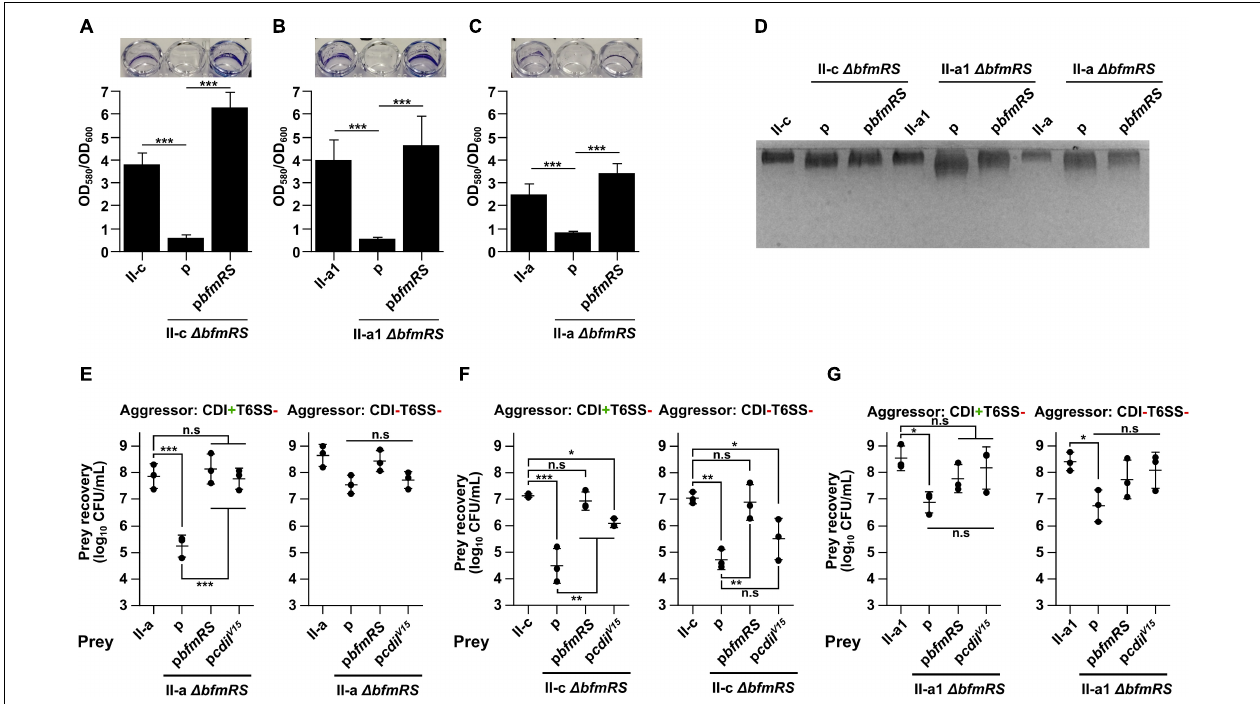
FIGURE 3 | (A–C) Evaluation of biofilms formed by A. baumannii strains II-c (A) , II-a1 (B) , and II-a (C) , their bfmRS mutants, and bfmRS mutants complemented with the wild-type bfmRS operon from A. baumannii V15. Biofilms were quantified from at least three independent experiments performed in duplicates and normalized by dividing by the total growth (OD 600 ). Pictures above graphs show macroscopic images of biofilms stained with crystal violet. (D) 12.5% SDS-PAGE gel stained with Alcian Blue showing capsular polysaccharide profiles of clinical strains I-c, II-a1, and II-a, their bfmRS mutants, and bfmRS mutants complemented with wild-type bfmRS operon. (E–G) Quantitative evaluation of inter-bacterial competition. Graphs show recovered numbers of A. baumannii clinical strains after being premixed with an aggressor at the aggressor:prey ratio of 1:1. A. baumannii clinical strains II-a (E) , II-c (F) , and II-a1 (G) , their bfmRS mutants, and bfmRS mutants complemented with either wild-type bfmRS operon from A. baumannii V15 or immunity gene cdiI V15 from the A. baumannii V15 strain were used as prey. Competitions were performed with the following A. baumannii V15 mutants used as aggressors: (cid:49) bfmRS (cid:49) hcp (CDI + T6SS - ), (cid:49) bfmRS (cid:49) hcp (cid:49) cdi V15 (CDI - T6SS - ). Error bars represent standard deviation. Horizontal lines represent mean value. Values were calculated from three independent experiments. Statistically significant differences are indicated by one asterisk (One-way ANOVA, p < 0.05), two asterisks (One-way ANOVA, p < 0.01), or three asterisks (One-way ANOVA, p < 0.001); n.s., not